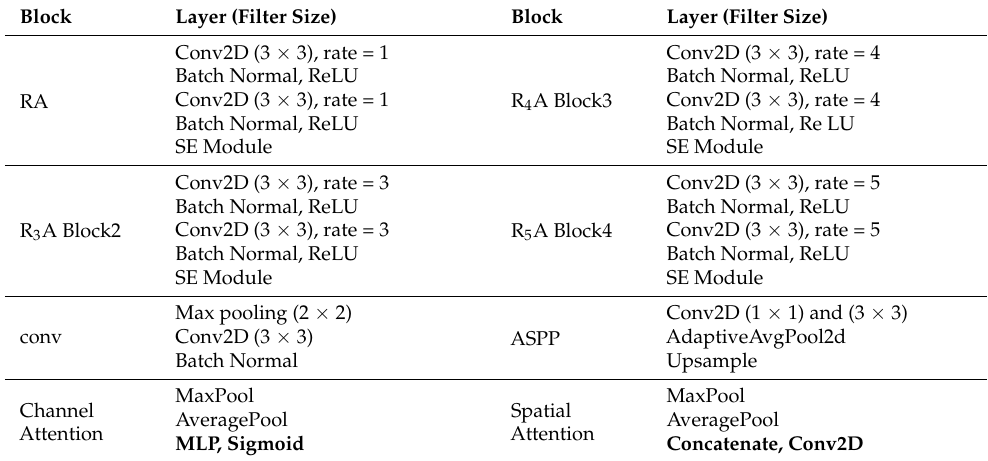
Table 1. MHAU-Net architecture details.